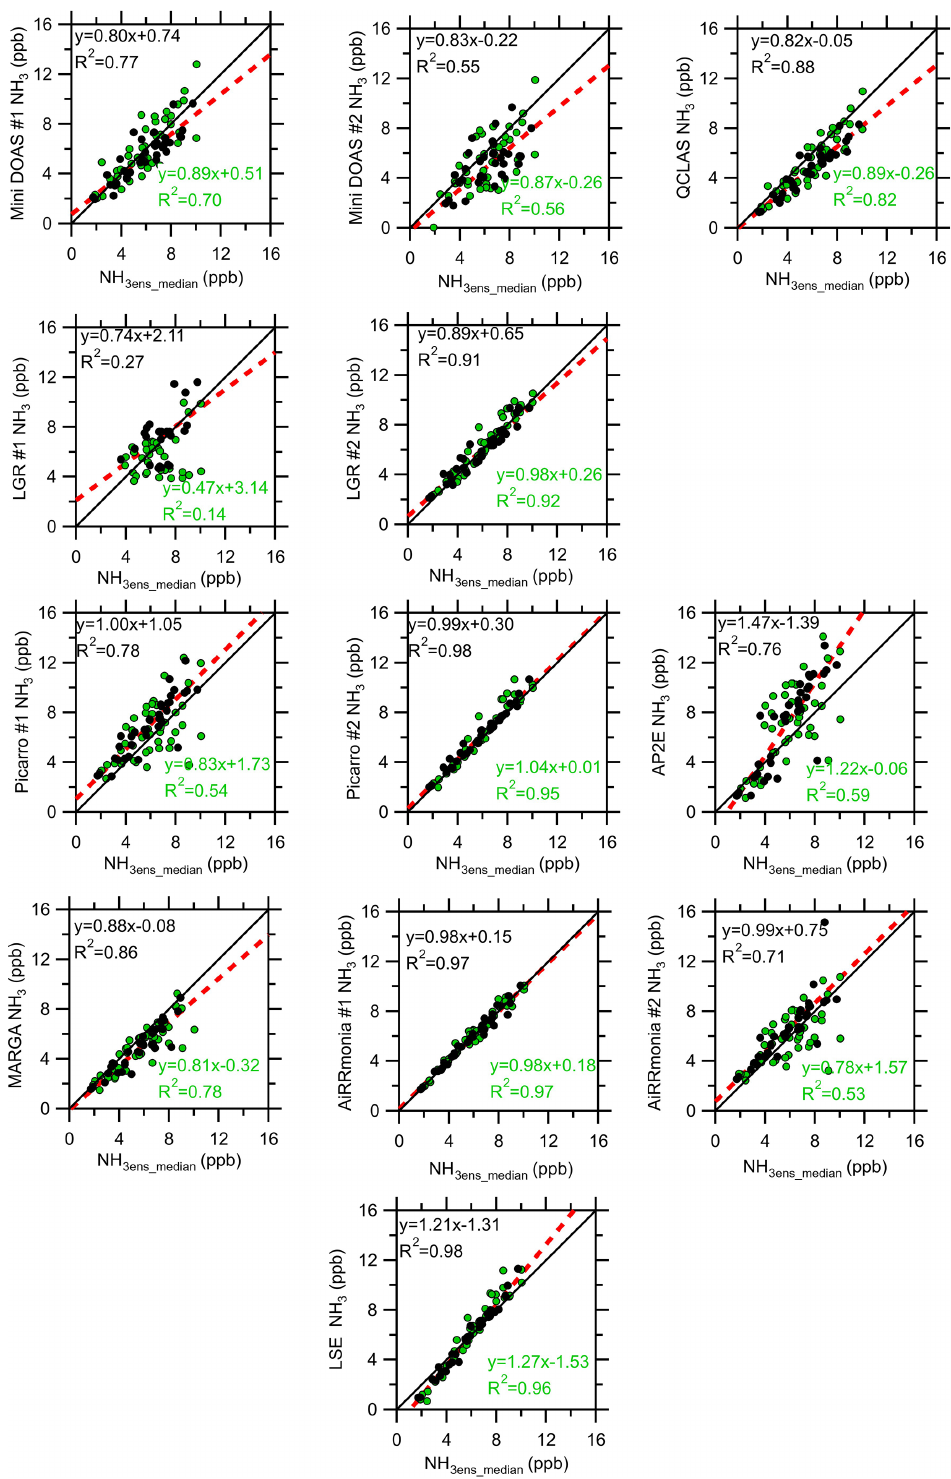
Figure 8. Intercomparison of hourly instrument averages from 22 to 29 August 2016 to the ensemble median (excluding LGR #1 and Tiger Optics) when the median < 10ppb NH 3 . Green circles are the data removed after applying a met filter ( < 0.8ms − 1 and | (z − d)/L | > 0 . 1). The green and black legends are the correlations of the unfiltered data and the filtered data, respectively. The solid black line is the 1:1 line, and the red dashed line is the